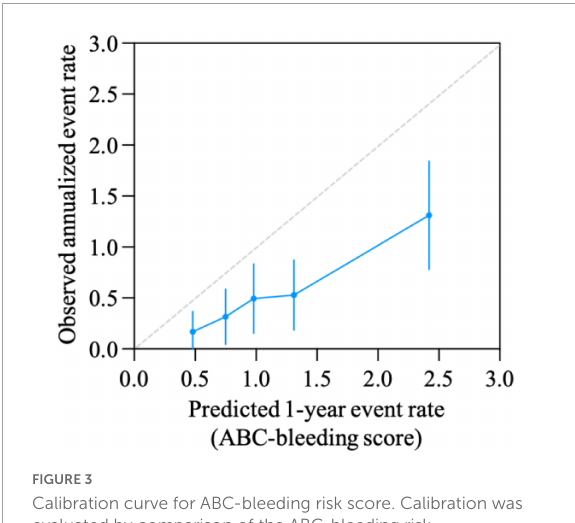
FIGURE3 Calibration curve for ABC-bleeding risk score. Calibration was evaluated by comparison of the ABC-bleeding risk score-predicted event rate and the observed annualized events rate.